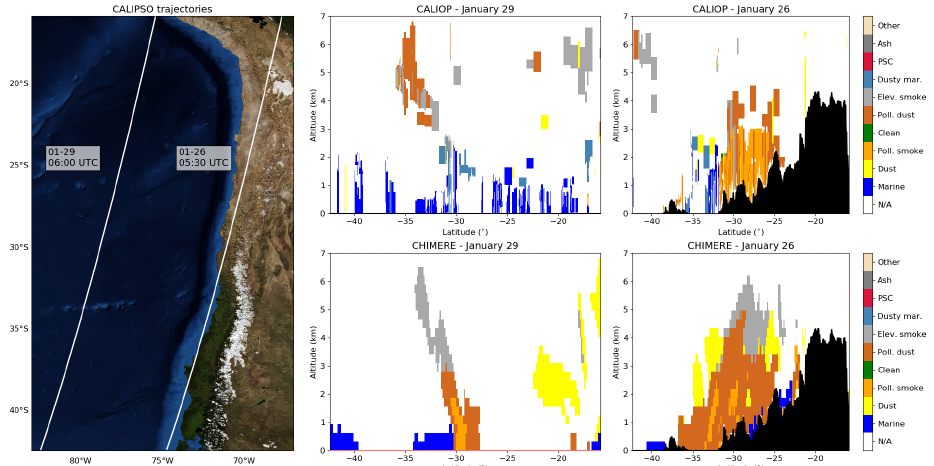
Figure 4. ( Left ) Trajectories of the CALIPSO legs for 26 and 29 January at 05:30 and 06:00 UTC, respectively, (white lines). Map background layer: Imagery World 2D, ©2009 ESRI. ( Middle and Right ) Vertical feature mask from CALIOP (top) and corresponding vertical feature mask extracted from CHIMERE for 26 and 29 January, respectively. Black filled contour shows terrain elevation along the